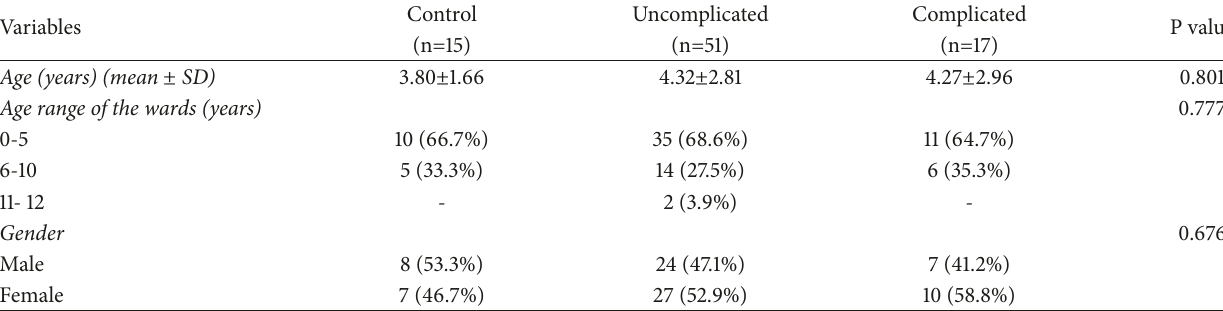
Table 1: Ages and gender of study participants.